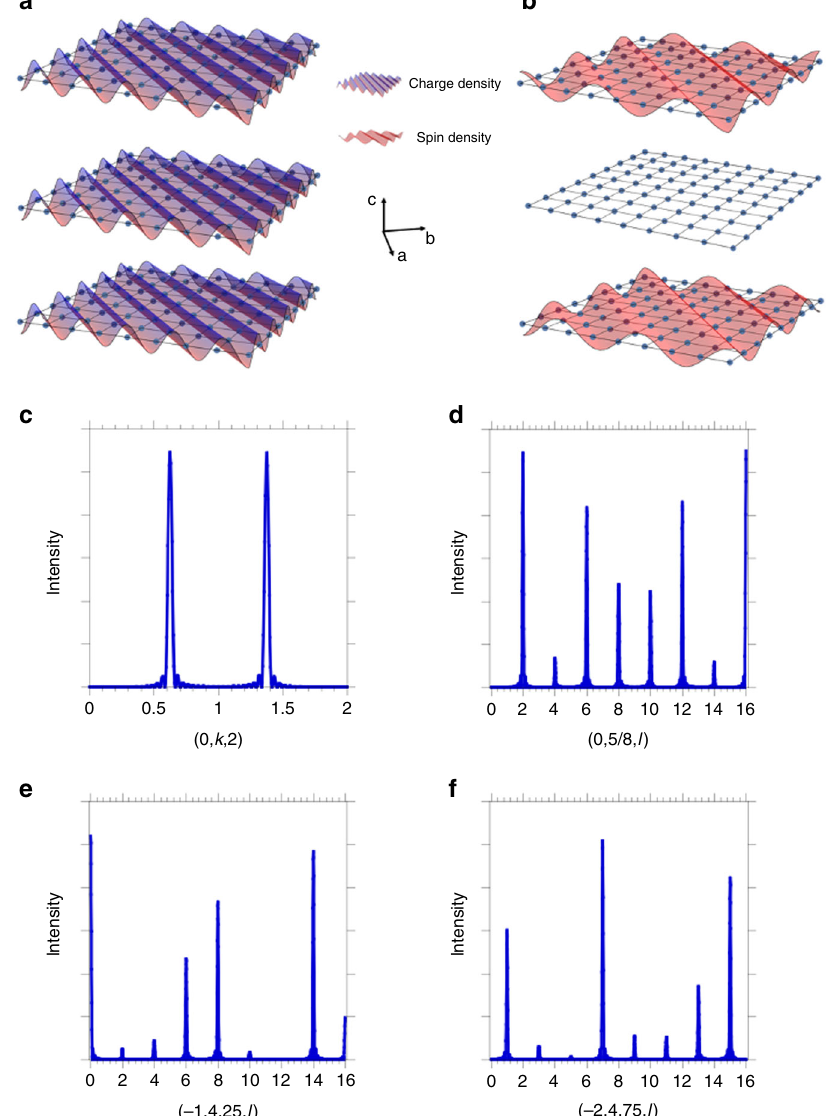
Fig. 4 Density wave simulations. a , b Model for the CDW and SDW plotted in the orthorhombic a-b plane. One trilayer is shown. For a , the CDW exists on all layers and is in-phase between the layers. For b , the SDW has a node on the inner plane and is out-of-phase between the two outer planes. In addition, the CDW in a is out-of-phase between trilayers, but the SDW in b is in-phase. c , d Predicted SDW diffraction intensities along k and along l . e , f Predicted CDW diffraction intensities along l . e and f differ in having either even or odd l